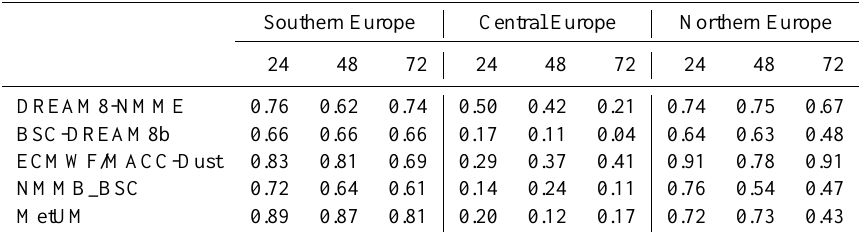
Table 4. Same as Table 2 but for Pearson correlation coefficient ( R